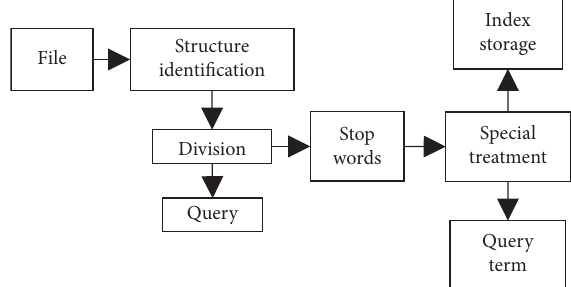
Figure 4: Query and analysis of digital documents of red education resources.